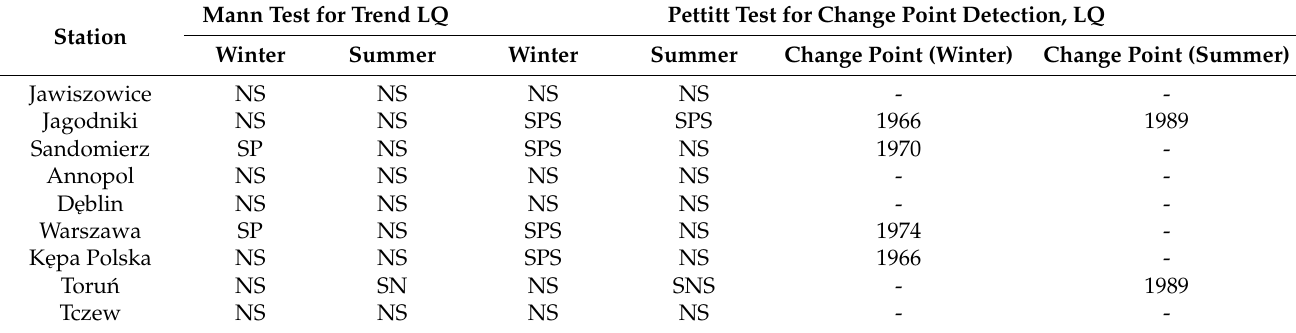
Table 6. The results of testing ( α = 0.05) for trend and change point in seasonal minimum flow (LQ) series in the 1951– 2018 period.